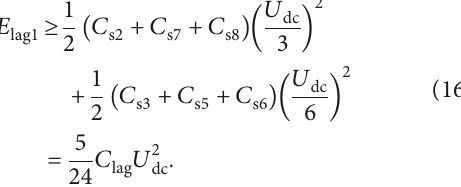
7 is turned off after